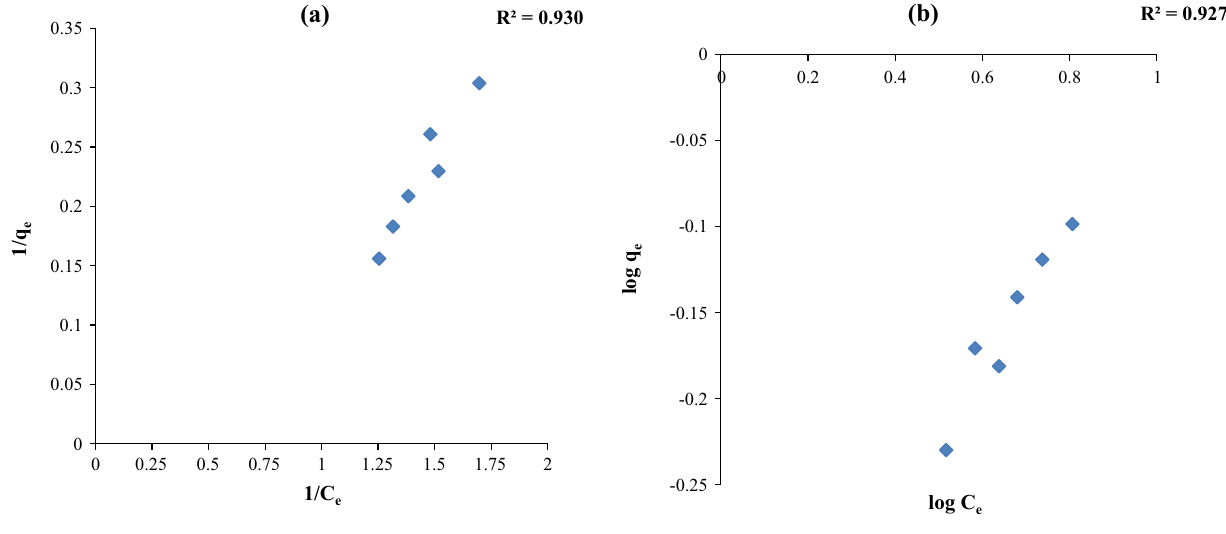
Table 4 Langmuir along with Freundlich isotherm constants and separation factor for the adsorption of Pb 2+ on bagasse biochar